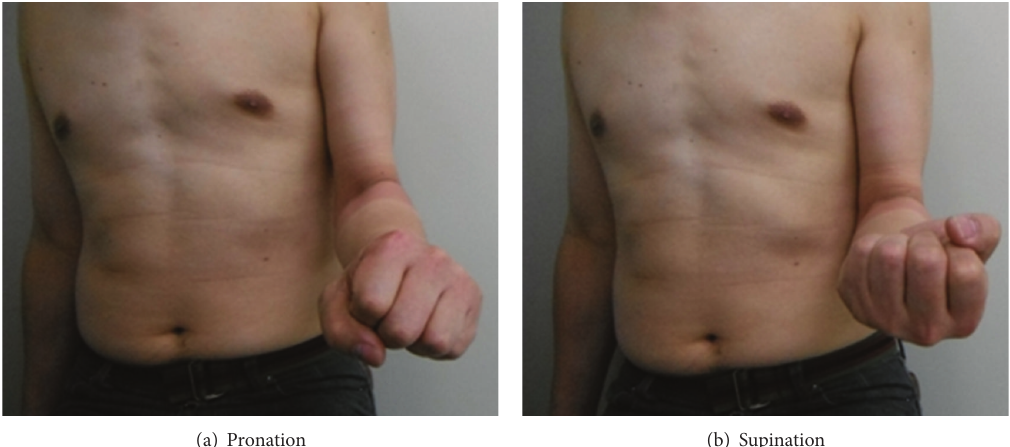
Figure 7: One year after the operation: (a) pronation; (b)